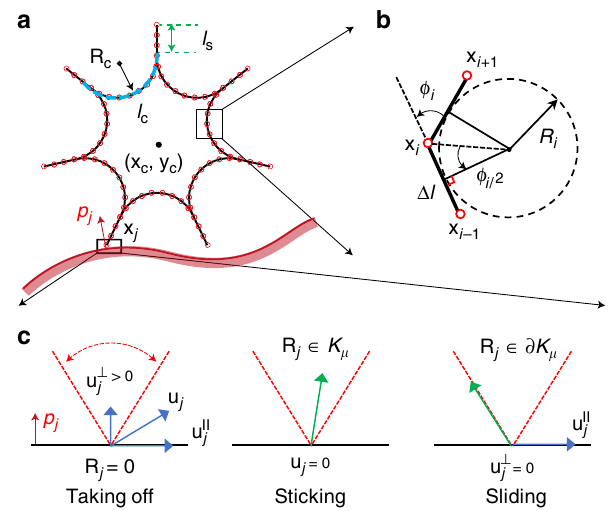
Fig. 1 Discrete kinematic representation of a soft robot. a